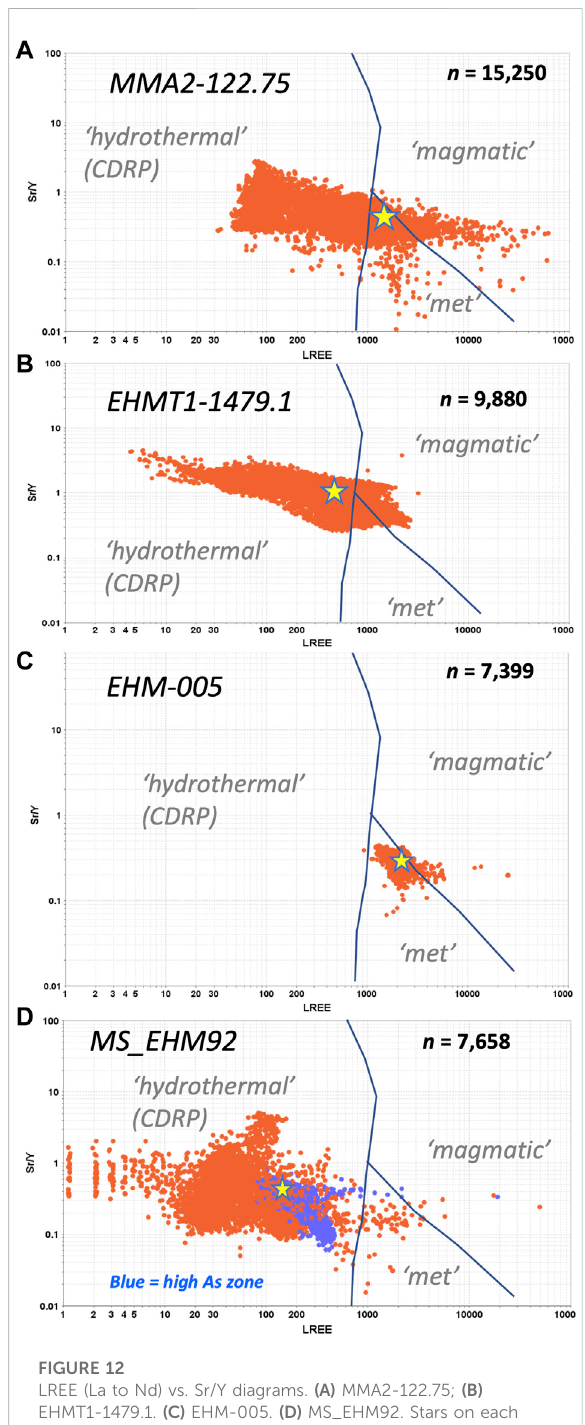
FIGURE 12 LREE (La to Nd) vs. Sr/Y diagrams. (A) MMA2-122.75; (B) EHMT1-1479.1. (C) EHM-005. (D) MS_EHM92. Stars on each diagram indicate the mean values for LREE and Sr/Y in each